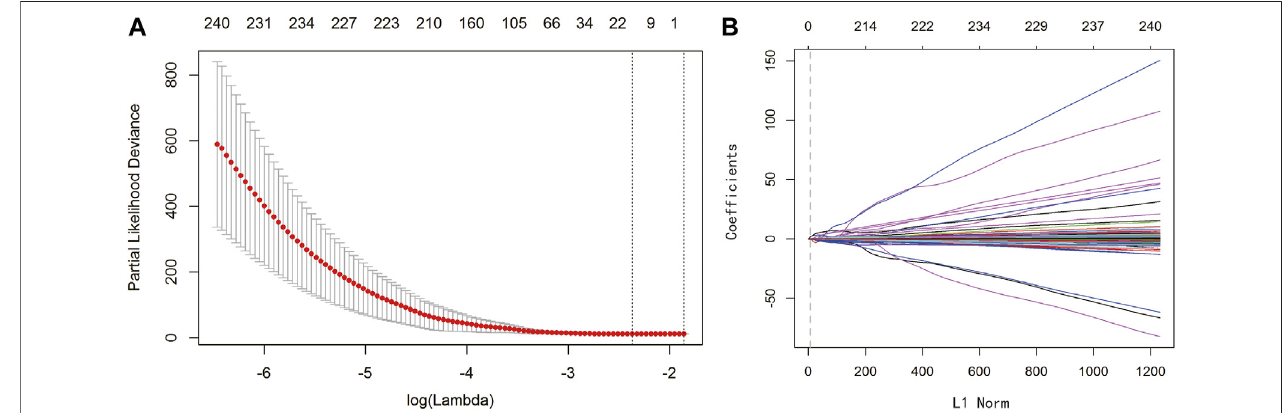
FIGURE2| LASSOregressionanalysisidenti fi edthree signi fi cantgenes. (A) LASSOdeviance pro fi les.The y -axisrepresents partiallikelihooddeviation.The x -axis represents the ideal gene feature amount on various lambda values. The two longitudinal dotted line indicates λ min (left) and λ 1-SE (right) , respectively. (B) LASSO coef fi cient pro fi les. The y -axis represents coef fi cients, and the x -axis represents L1 Norm. The vertical dotted line indicates that variables intersecting the corresponding penalty value are fi nally included in the model, and the corresponding ordinates of the variables are the weighting coef fi cients.